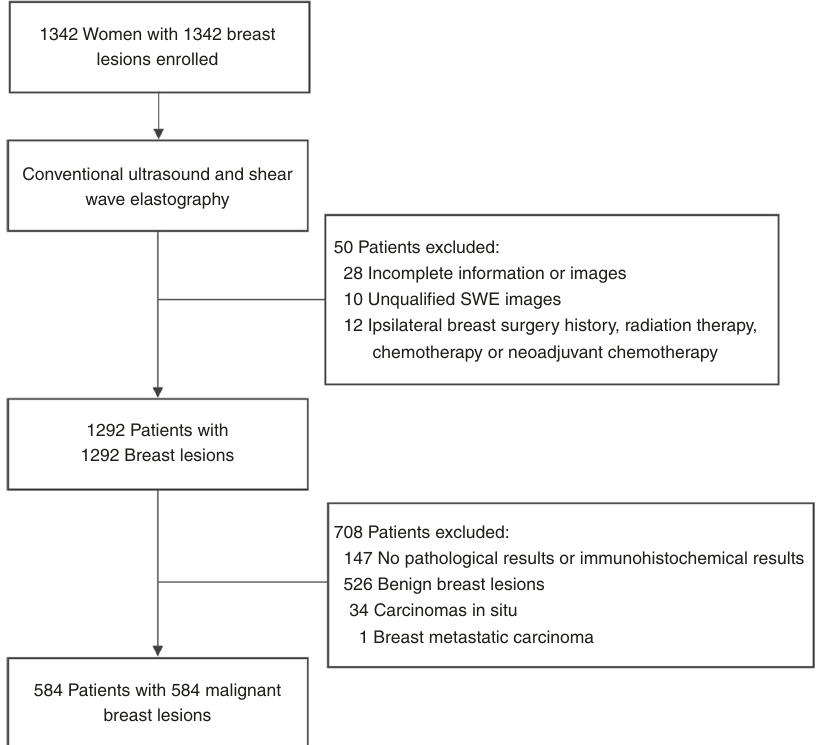
Fig. 1 Patient recruitment work fl ow. In total, 584 out of 1342 patients were included according to the selection criteria. The included patients were examined by conventional US and SWE, and had complete clinical information needed for the study.